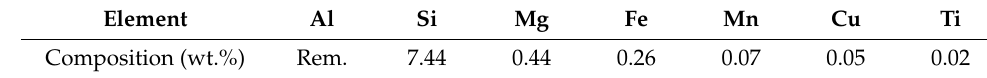
Table 1. The chemical composition of the A356 substrate. Element Composition (wt.%)